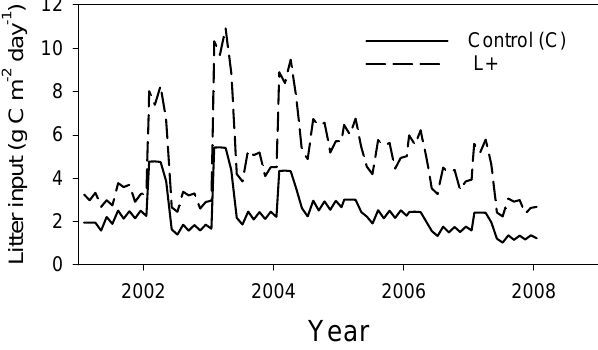
Figure 4. Mean monthly total (above- and belowground) litter car- bon input to the control or litter addition